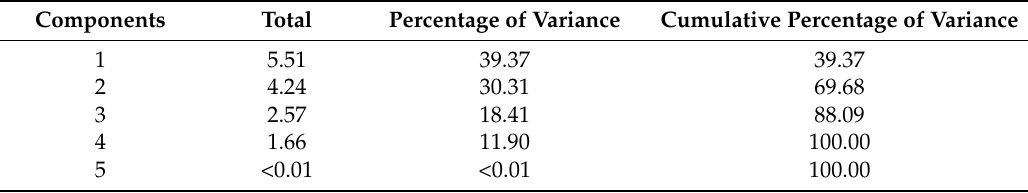
Table 3. Eigenvalues and explained variance using